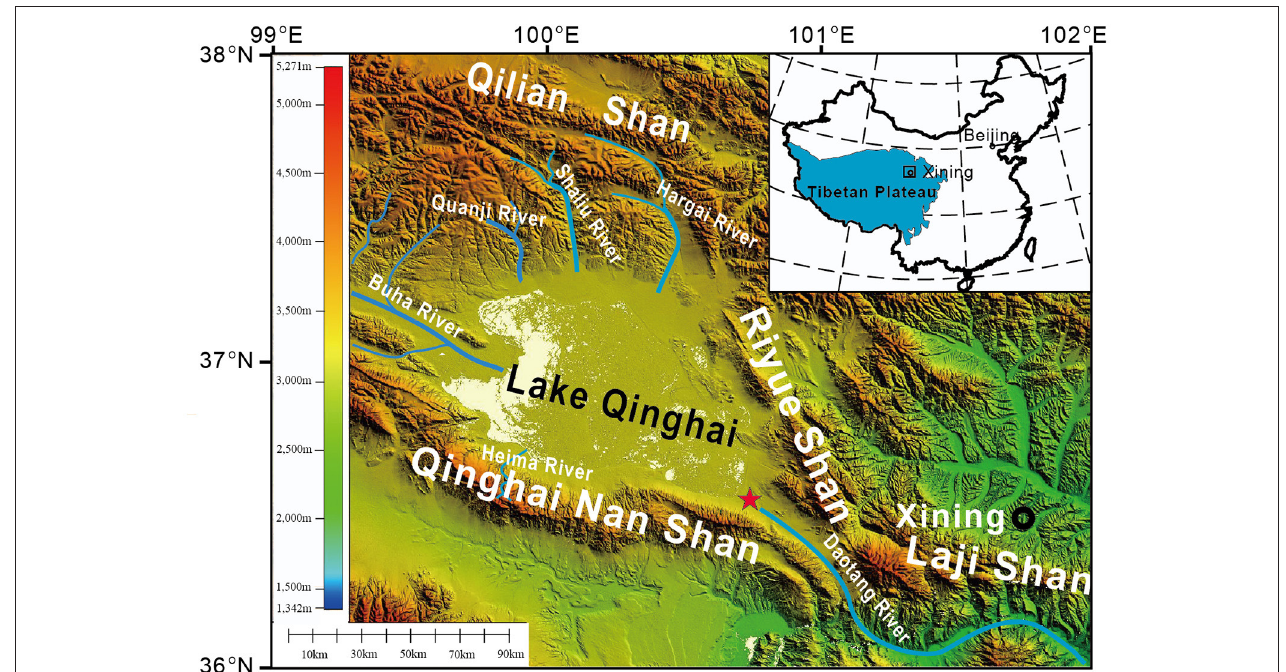
FIGURE 1 | Schematic location map showing the location of Lake Qinghai. Red five-pointed star, the sampling site.